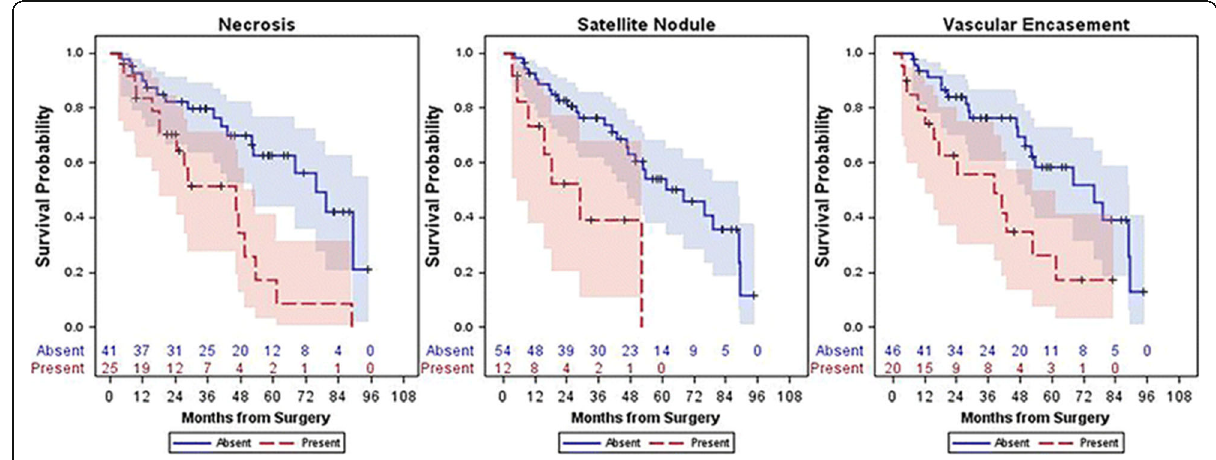
Fig. 5 Kaplan – Meier survival curves which illustrate that the presence of necrosis, satellite nodules, and vascular encasement were all associated with decreased survival. Reprinted with permission from: Aherne EA, Pak LM, Goldman DA, Gonen M, Jarnagin WR, Simpson AL, and Do RK. Intrahepatic cholangiocarcinoma: can imaging phenotypes predict survival and tumor genetics? Abdom Radiol, 2018, 43